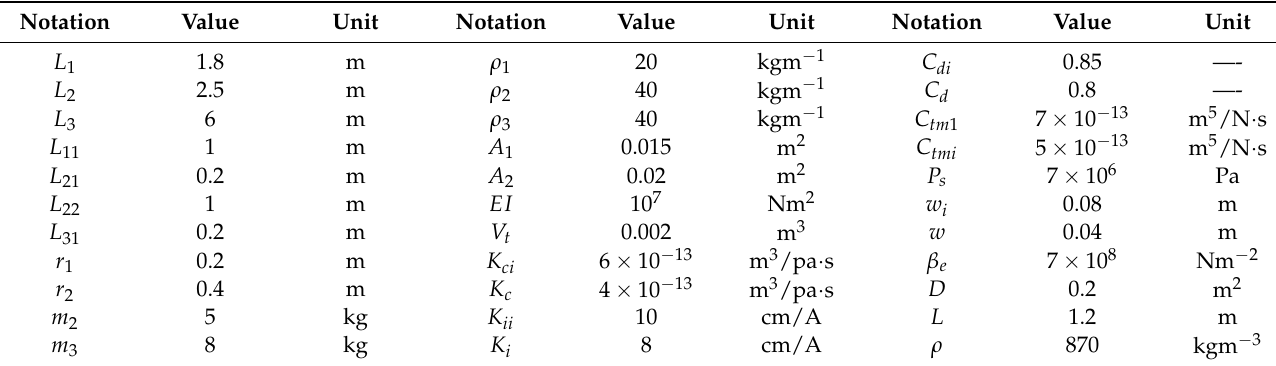
Table 3. HDFRMS structure parameters.